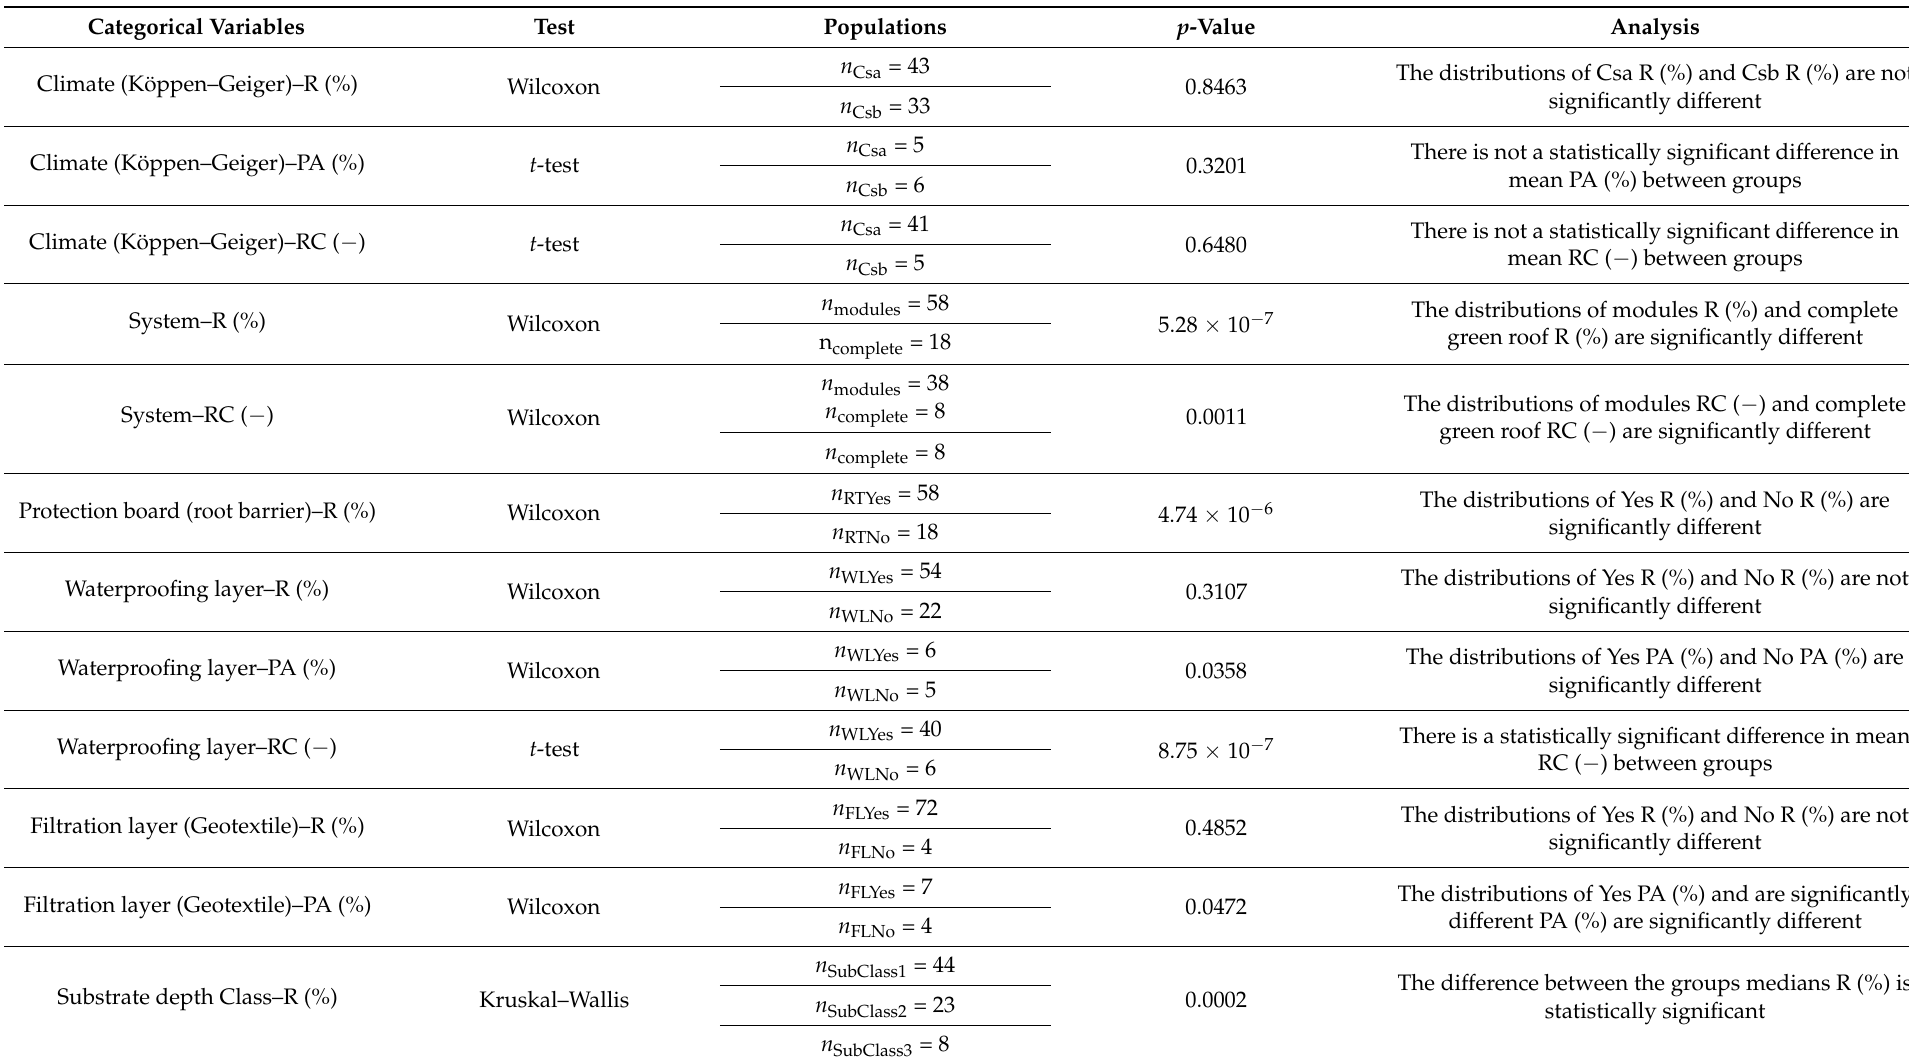
Table 5. P -values obtained with the statistical tests for all the categorical